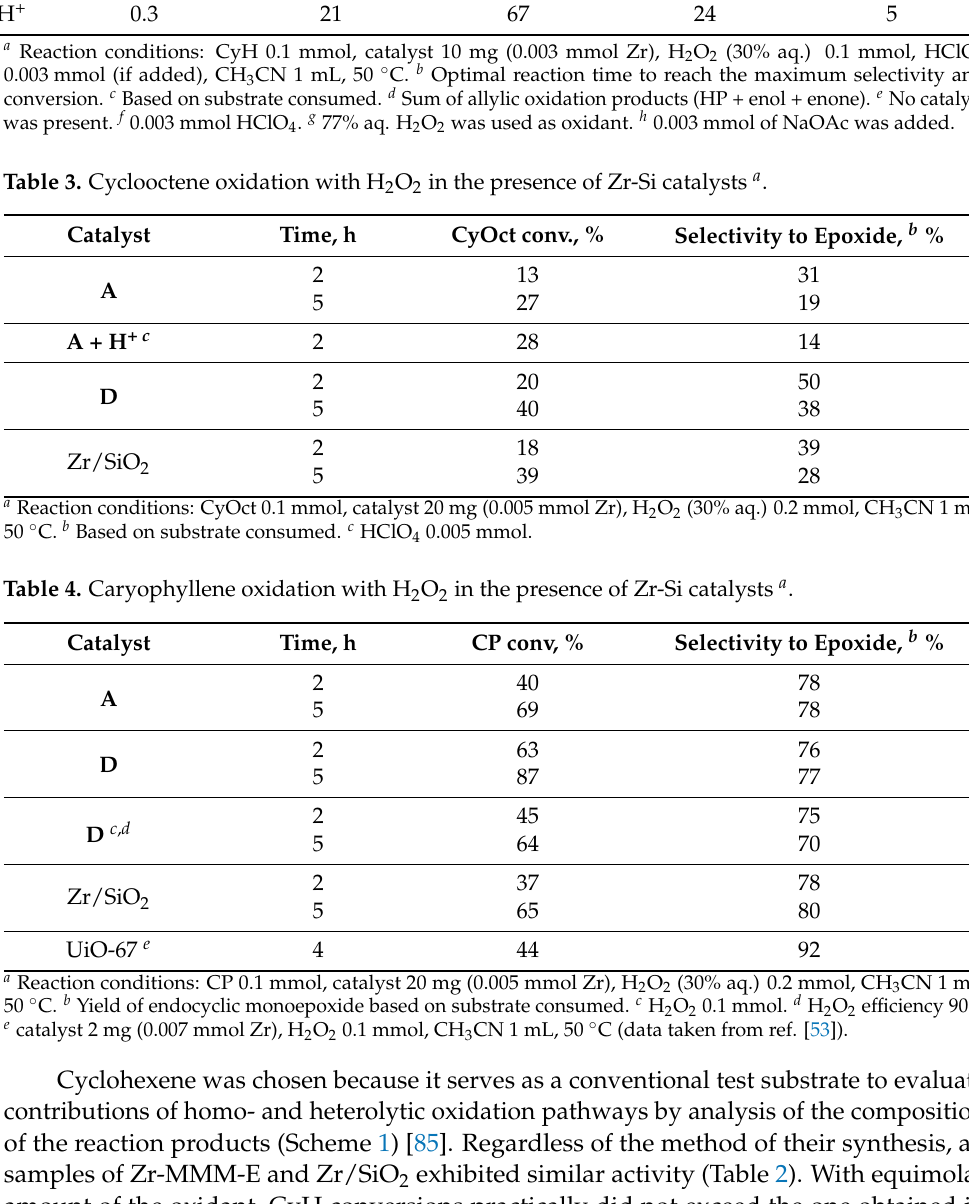
Cyclohexene was chosen because it serves as a conventional test substrate to evaluate contributions of homo- and heterolytic oxidation pathways by analysis of the composition of the reaction products (Scheme 1) [85]. Regardless of the method of their synthesis, all samples of Zr-MMM-E and Zr/SiO 2 exhibited similar activity (Table 2). With equimolar amount of the oxidant, CyH conversions practically did not exceed the one obtained in a ‘blank’ experiment with no catalyst (Table 2, entry 1). However, the amount of the two- electron oxidation product epoxide increased in comparison to the amount of one-electron (allylic) oxidation products, cyclohexenyl hydroperoxide (HP), 2-cyclohexene-1-ol (enol), and 2-cyclohexene-1-one (enone) (compare entry 1 with entries 3, 7, 9, 11 and